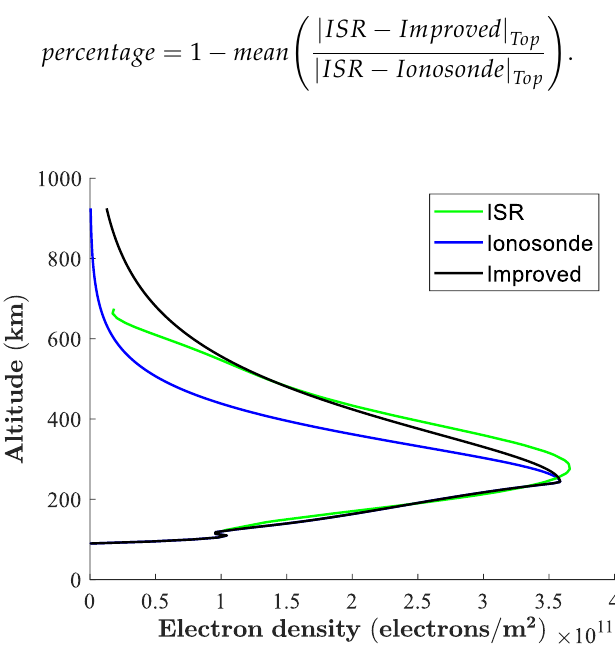
Figure 5. Electron density profiles for ISR and ionosonde.